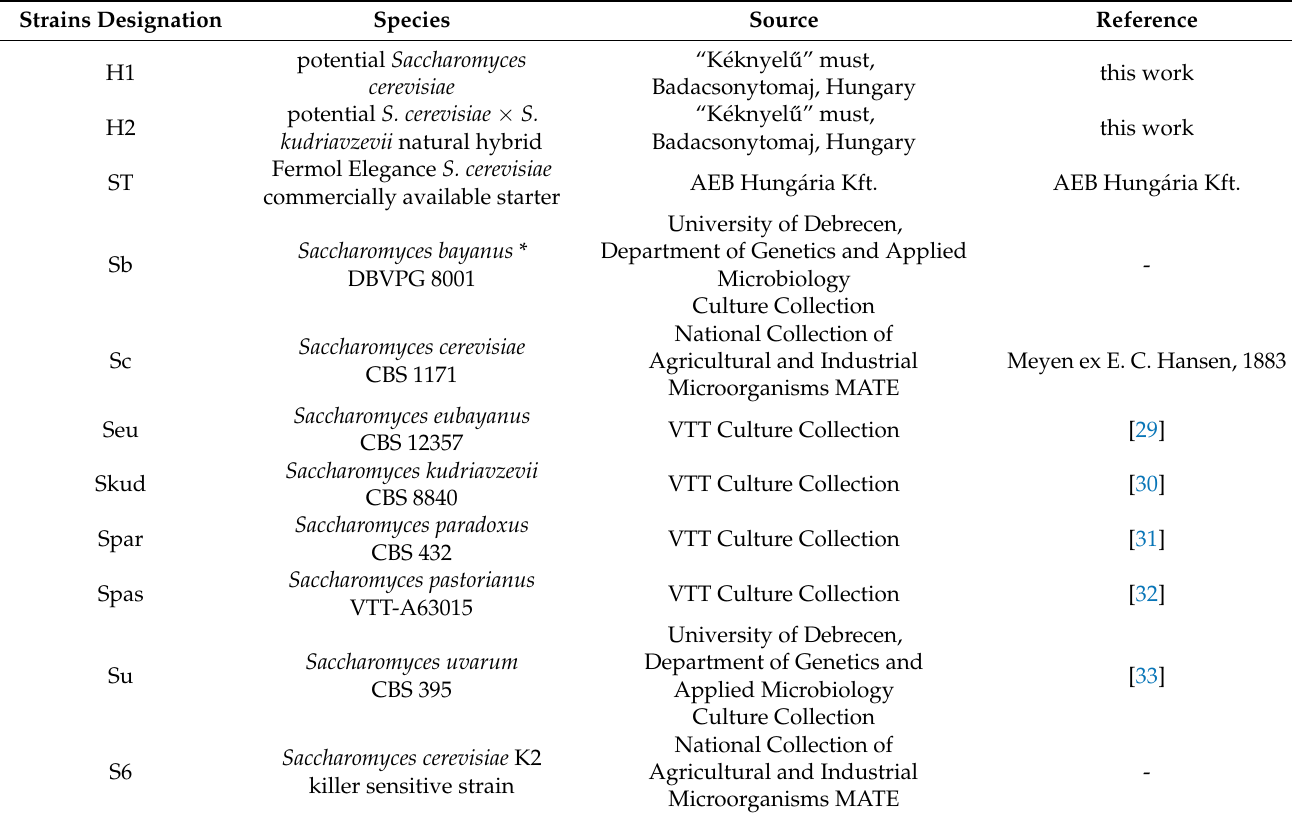
Table 1. A list of strains used in this